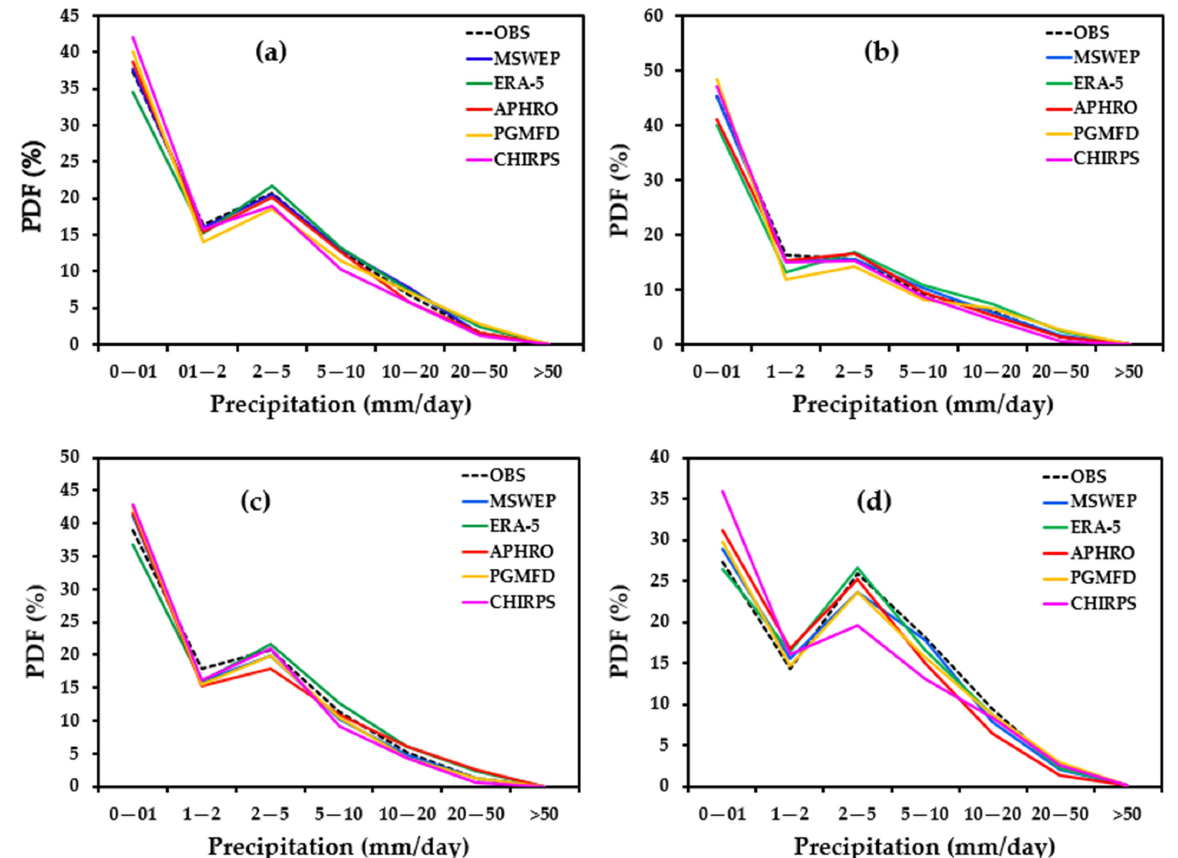
Figure 7. The probability density function (PDF) of GPPs with diverse intensities during ( a ) entire study period, ( b ) winter, ( c ) pre-monsoon, and ( d ) monsoon.